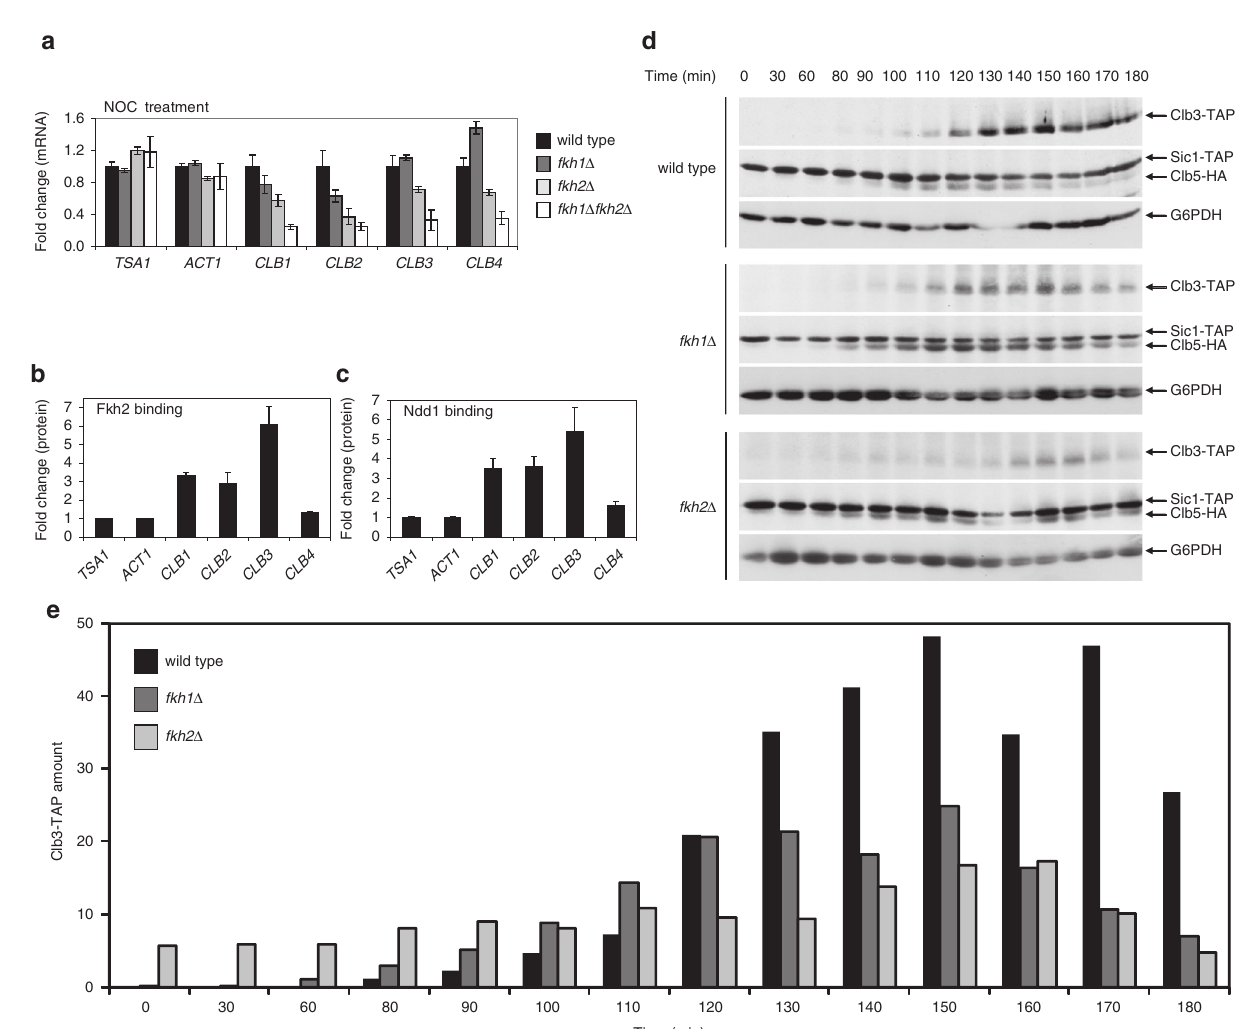
Fig. 2 Fkh1 and Fkh2 regulate dynamics of mitotic Clb cyclins in a cell cycle-dependent manner. a Quantitative real-time PCR of mitotic CLB transcripts in yeast cells treated with nocodazole (NOC). Total mRNA was isolated from arrested wild type, fkh1 Δ , fkh2 Δ , and fkh1 Δ fkh2 Δ cells, and CLB1 , CLB2 , CLB3, and CLB4 mRNA levels were measured. ACT1 and TSA1 genes were used as negative controls, as they are not affected by cell cycle dynamics. Error bars on the histograms represent SDs from the mean of three independent experiments; p -values are indicated on the histograms in Supplementary Fig. S2a. Nocodazole-arrested cells show that fkh2 Δ affects both CLB3 and CLB4 transcript accumulation, whereas fkh1 Δ affects CLB4 transcript accumulation. b , c Binding of Fkh2 ( b ) and Ndd1 ( c ) to mitotic CLB promoter regions. Chromatin immunoprecipitation was performed by precipitating protein/DNA complexes from cells grown in exponential phase using an anti-Myc antibody. ACT1 and TSA1 genes were used as negative controls, whereas CLB1 and CLB2 genes as positive controls. Error bars on the histograms represent SDs from the mean of three independent experiments. d , e Fkh2 controls the timing of Clb3 protein expression. d Time course of Clb2-18Myc, Clb3-TAP, Clb5-HA and Sic1-TAP are shown for wild type (YAN49), fkh1 Δ (YAG20), and fkh2 Δ (YAG21) strains. Yeast cells were synchronized by centrifugal elutriation in YPD at 30 °C, released into fresh YPD at 30 °C, and sampled for western blot analysis at the indicated times. Clb3 levels were quanti fi ed in wild type, fkh1 Δ and fkh2 Δ strains ( e ). The experiments were performed at the same time, and the membranes processed identically, with the same antibody aliquots and then exposed to the same levels. fkh1 Δ resulted in an decreased amount of Clb3 produced and no time delay as compared to wild type, whereas fkh2 Δ resulted in both a decreased amount of Clb3 produced and a time delay as compared to wild type. The result is representative of three independent